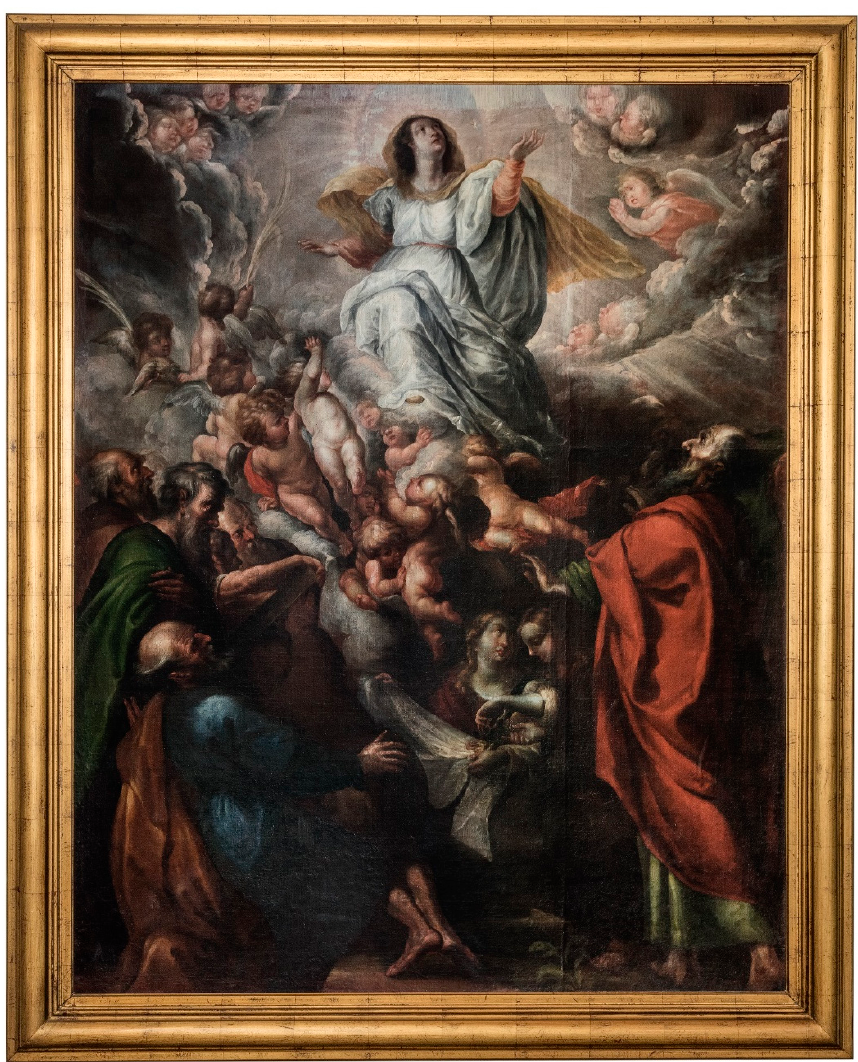
Figure 2. Cristóbal de Villalpando, La Asunción (end of the 17th–beginning of the 18th century), oil on canvas, 198 × 168.3 cm, Museo Regional de Guadalajara, Guadalajara. Photograph by: Gerardo Hernández Rosales. Reproduction authorized by the Instituto Nacional de Antropología e Historia. Both paintings share the same size and format (198 × 168.3 cm) . La Asunci ó n